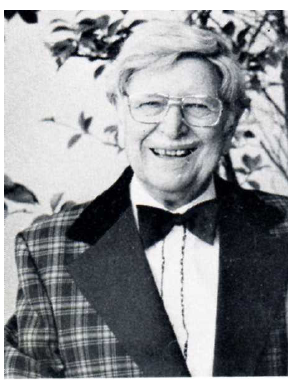
Figure 4. Eugene La Fond (source: IAPSO archives).